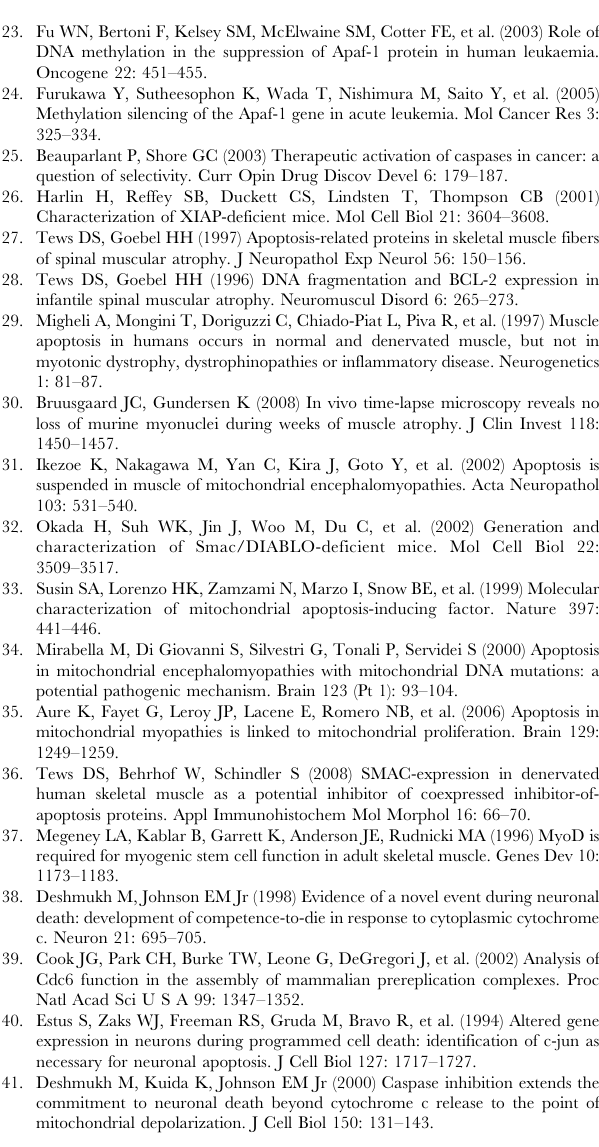
Figure S1 tBid induces the release of cytochrome c from mitochondria in differentiated C2C12 (dC2C12) cells. dC2C12 cells were injected with plasmids for tBid or empty vector, as well as GFP, in the presence of the caspase inhibitor Q-VD-OPH (to prevent cell death). 24 h after the injections, cells were immunostained with an antibody to cytochrome c. Arrows point to the injected cells. Control GFP alone expressing cells show cytochrome c staining (upper panel) which is lost upon its release from the mitochondria in tBid expressing cells (lower